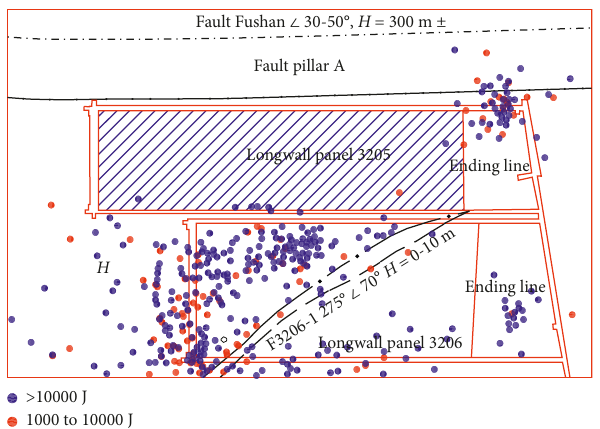
Figure 8: Seismic events between February 2, 2013, and September 16, 2013 (modified from [33]). Two different color dots are employed to show the energy of seismic events.